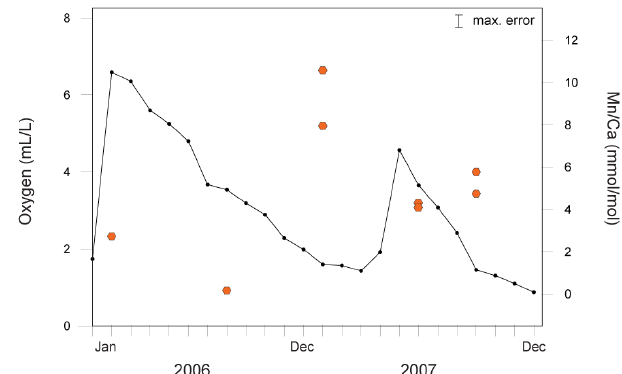
Fig. 4b. Mn/Ca of G. turgida (hexagons, orange) from the Gullmar Fjord vs. dissolved oxygen concentrations in the water column for 2006 and 2007. When bottom water dissolved oxygen decreases, Mn/Ca in G. turgida increases. Maximum error corresponds to the largest analytical error for the displayed samples.